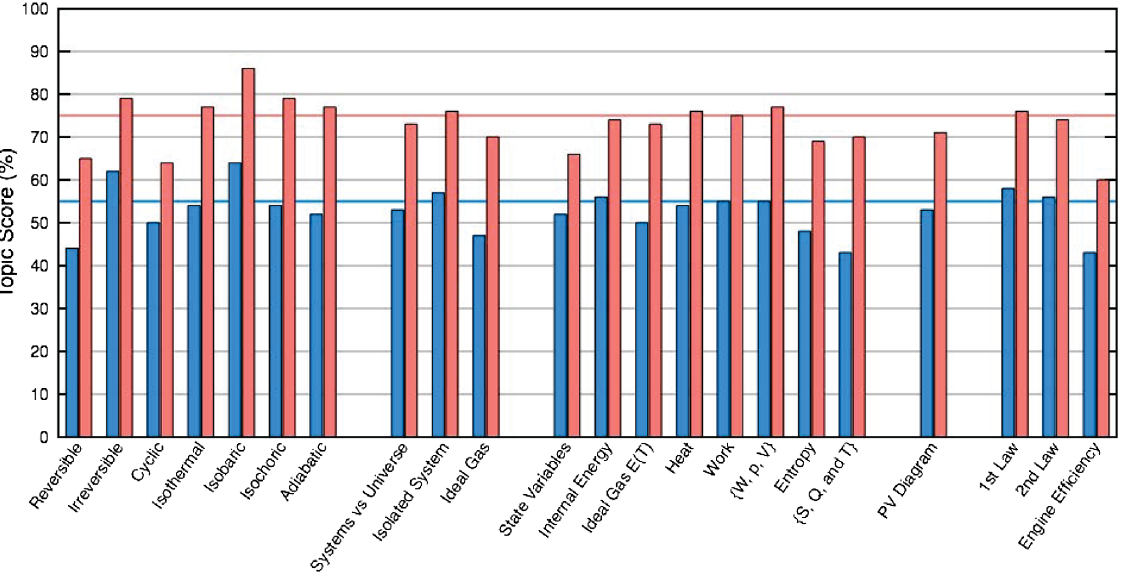
FIG. 6. Average percentage scores for first-year physics Ph.D. students individually and in pairs on the STPFaSL instrument by topic (for individual Ph.D. students, the number of students N ¼ 45 , blue, and for the paired test, N ¼ 21 , red). The blue and red horizontal lines show the averages for those groups on the entire survey